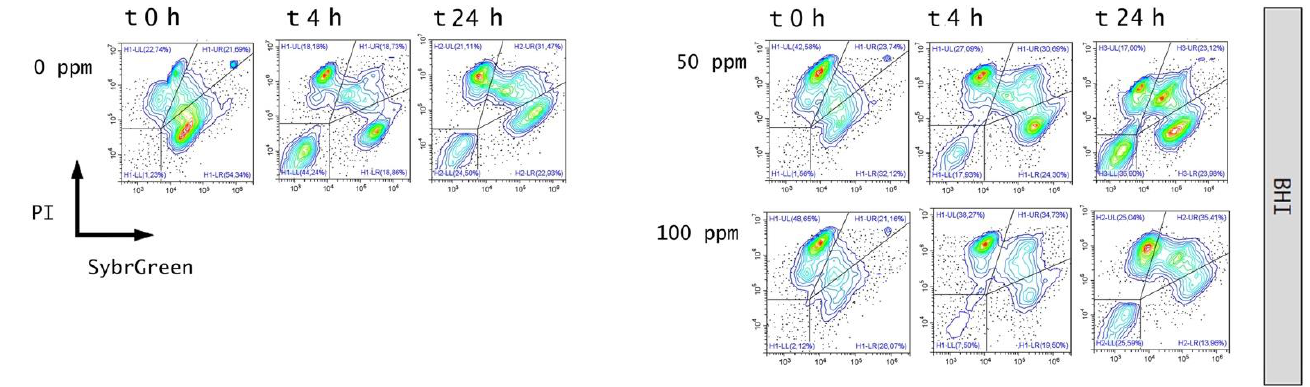
Figure 3. Double-staining density dot plot of E. coli cells in BHI broth diluted in PBS (pH 7.4): 50 ppm and 100 ppm essential oil treatment compared to 0 ppm (control) (at 0, 4 and 24 h of incubation). Cells were stained with SYBR Green I and PI simultaneously. H1-LL: unstained debris; H1-LR: intact cells/viable cells (SYBR Green I); H1-UR: injured cell population; H1-UL: permeabilized/dead cells (PI). In the upper right side of the plot, a defined single population represents standard beads.